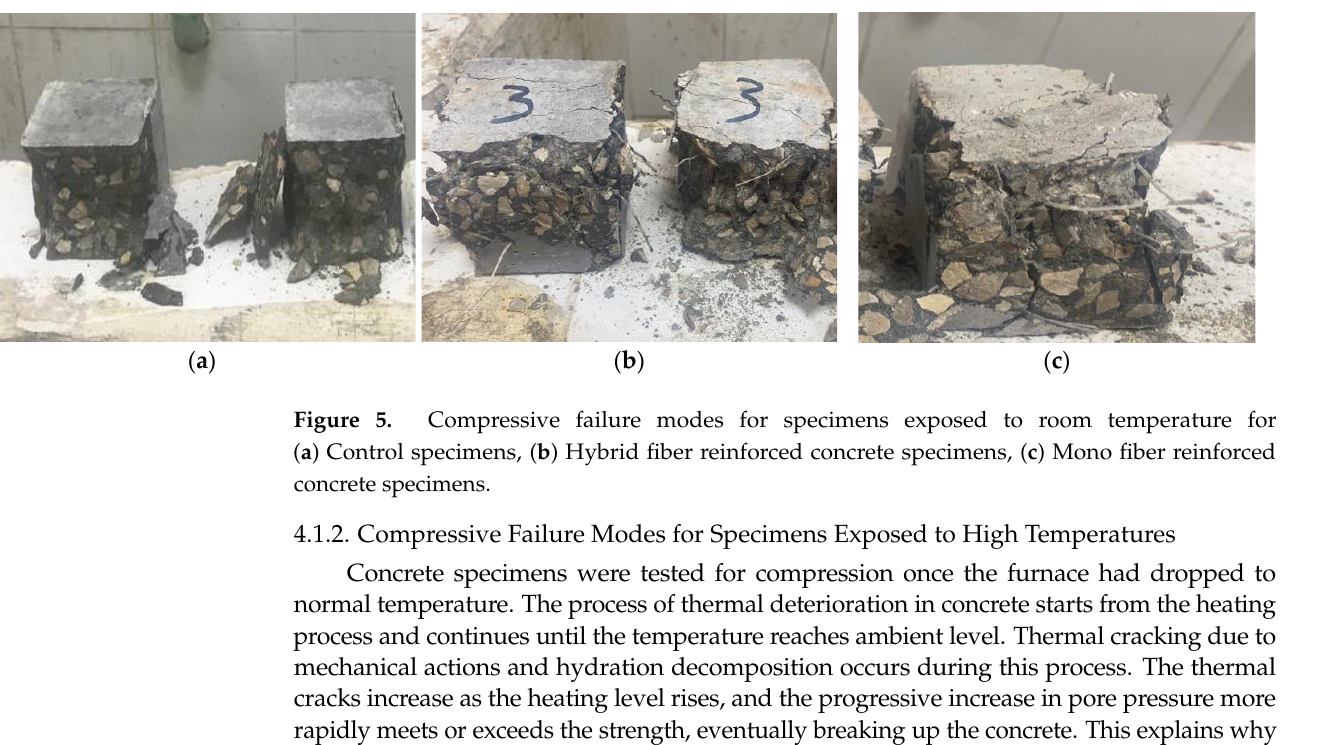
Figure 4. Flexural strength for all concrete specimens under ambient conditions.